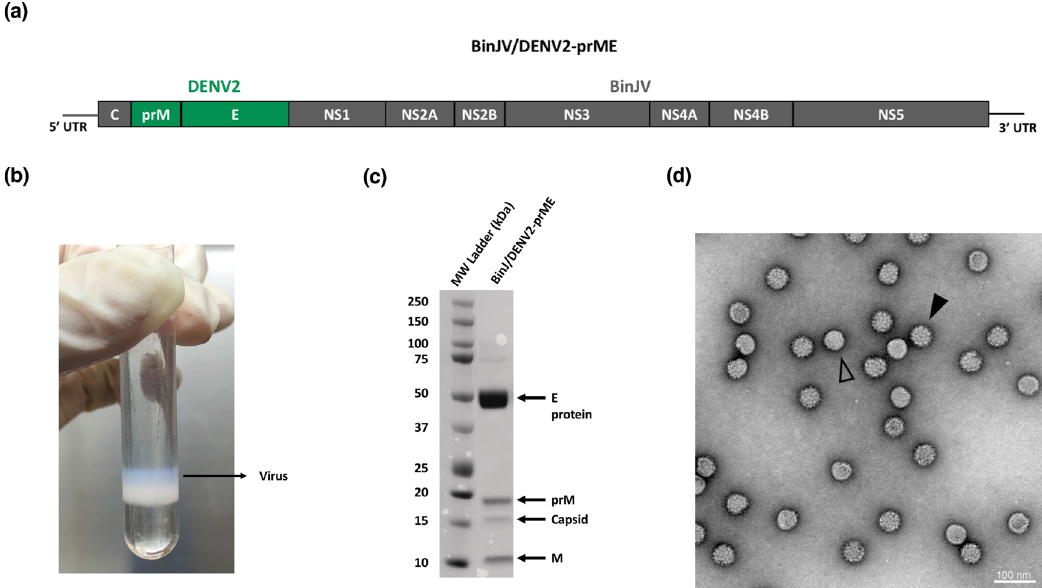
Fig. 1 BinJ/DENV2-prME vaccine antigen production and analysis. a BinJ/DENV2-prME chimeric virus genome schematic with the prM/E genes of DENV2 indicated in green and BinJV capsid (C) and NS genes in grey. b BinJ/DENV2-prME was puri fi ed via a potassium tartrate gradient, sedementing as a wide opalescent blue band. c SDS-PAGE (4 – 12%) analysis of gradient-puri fi ed BinJ/DENV2-prME. Flavivirus structural proteins (pre-membrane (prM), C, membrane (M) and envelope (E) protein) are indicated. Gels were derived from the same experiment and processed in parallel. d Negative-stain TEM image of BinJ/DENV2-prME at ×30,000 magni fi cation, highlighting representative mature (open arrowheads) and immature (closed arrowheads) viral